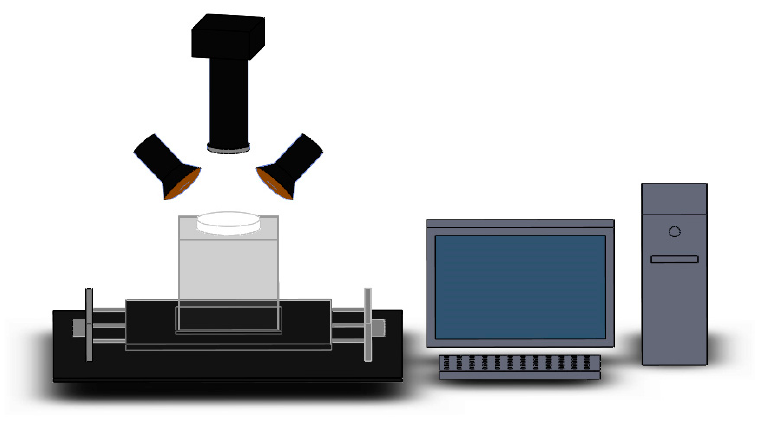
Figure 4. Hyperspectral imaging system.